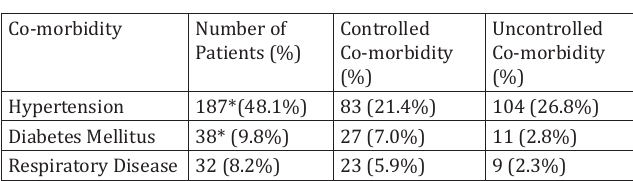
Distribution of systemic co-morbidities among the 388 study participants